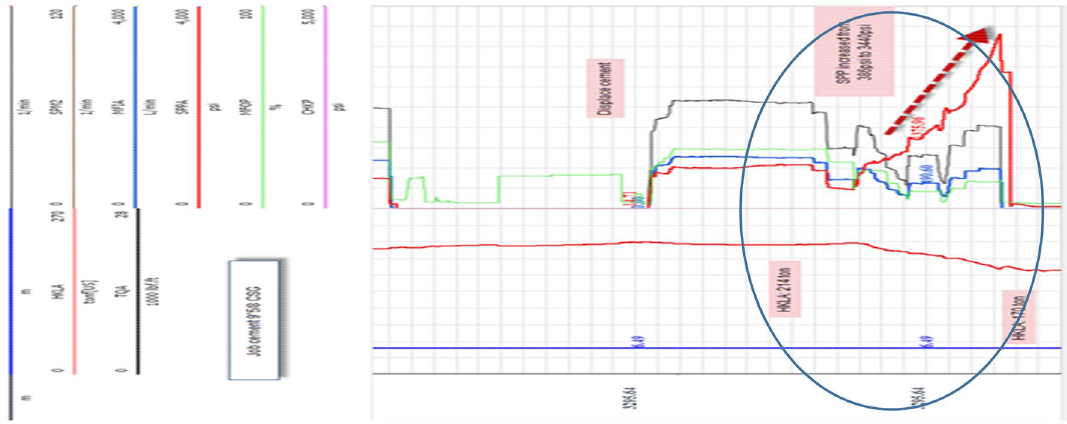
Fig. 11 9 ′ ’ 5/8 casing cement job